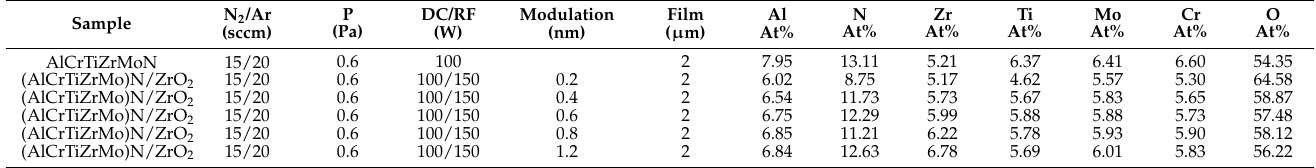
Table 1. The deposition parameters and the element contents of the (AlCrTiZrMo)N/ZrO 2 nano- multilayered films.